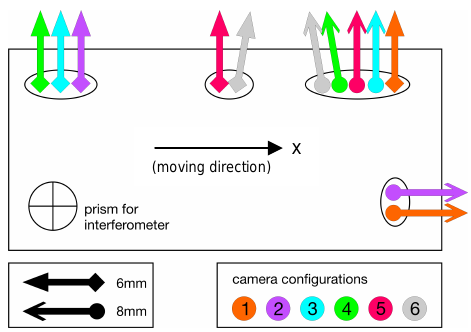
Figure 7. Camera configurations for scenario II. See expla- nation of Figure 6.